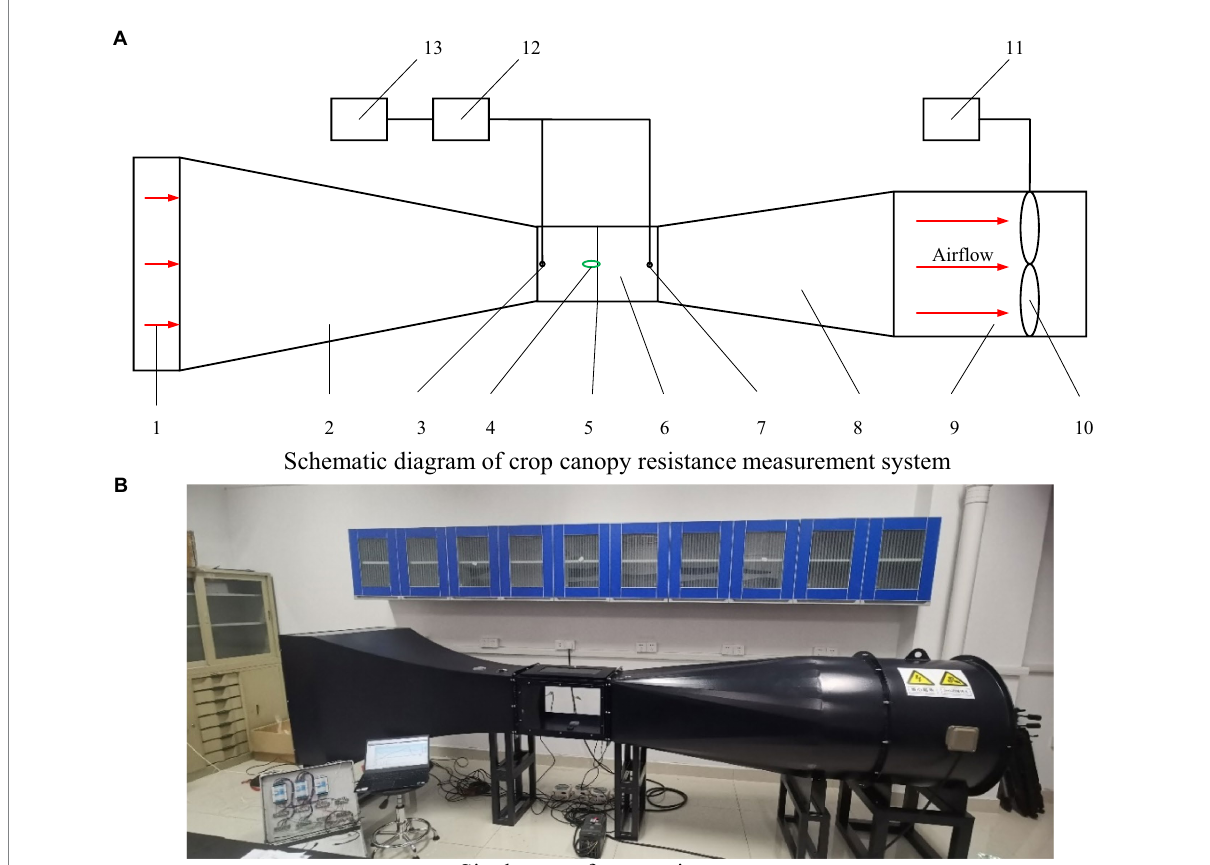
FIGURE 5 Measurement system of crop canopy resistance characteristics. (A) Schematic diagram of crop canopy resistance measurement system. (B) Site layout of test equipment. 1. Rectifier air inlet; 2. Contraction section; 3. Airflow velocity sensor and pressure sensor; 4. Leaf sample; 5. Leaf sample- fixing device; 6. Test section; 7. Pressure sensor; 8. Diffusion section; 9. Power section; 10. Axial flow motor; 11. Frequency converter; 12. Data collector; 13.